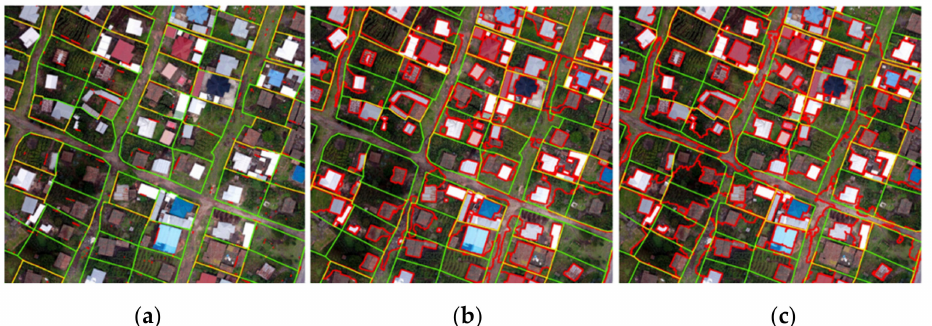
Figure 11. Xue et al. [282] compared three emerging feature extraction approaches for parcel boundaries: ( a ) fully convolutional networks (FCNs); ( b ) globalised probability of boundary (gPb); ( c ) multi-resolution segmentation (MRS). Note: Yellow lines are ‘true positive’; red lines are ‘false positive’; and green lines are ‘false negative.’